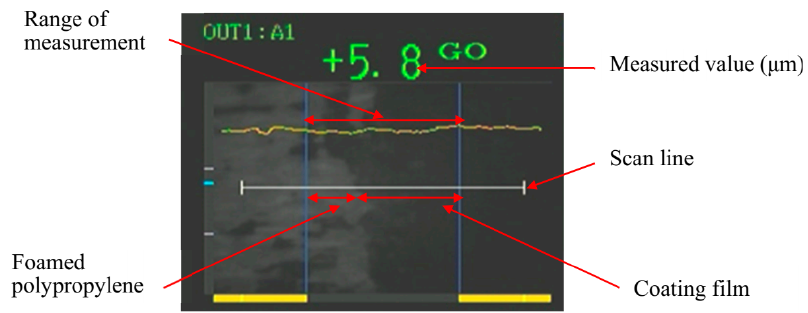
Figure 19. Screen copy when measuring the thinnest part.